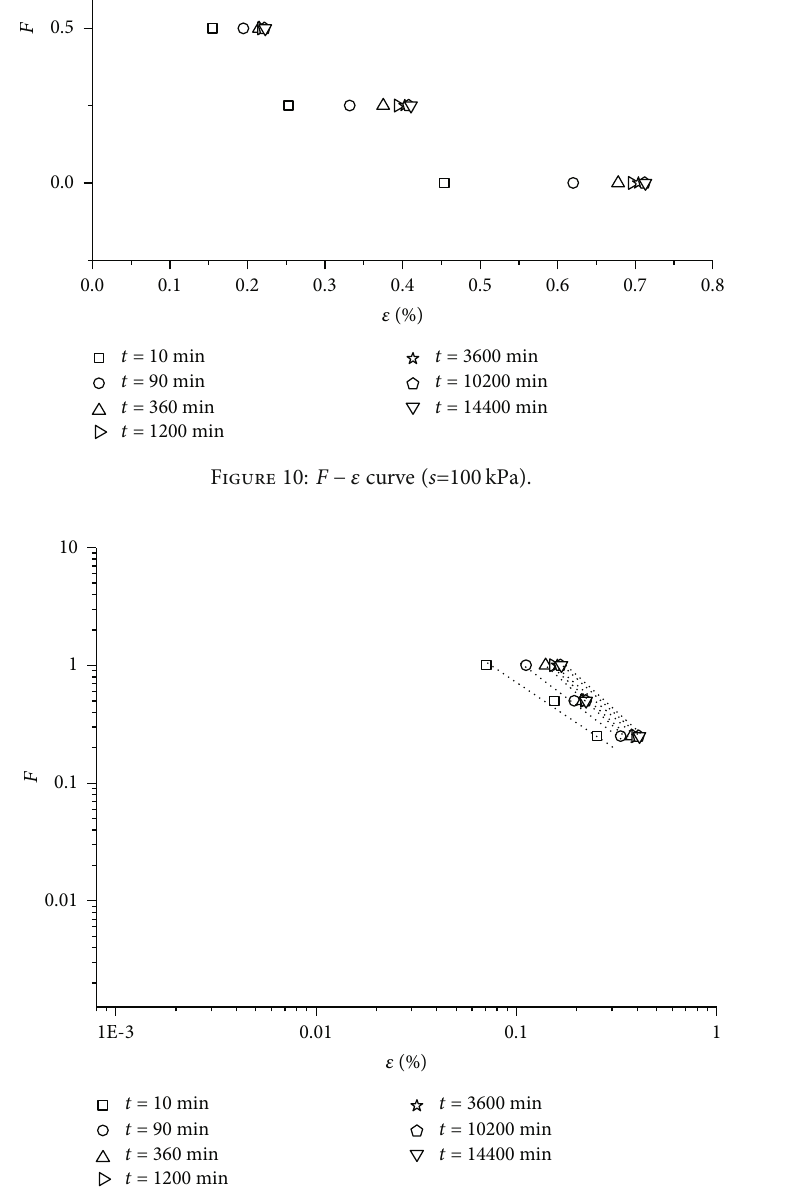
Figure 11: F − ε curve ( s =100kPa).